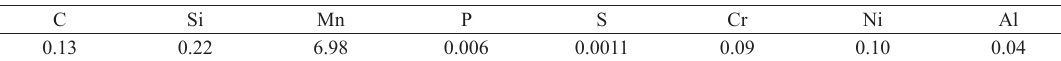
Table 1. Chemical composition of 0.13C-6.98Mn experimental steel (Wt %).